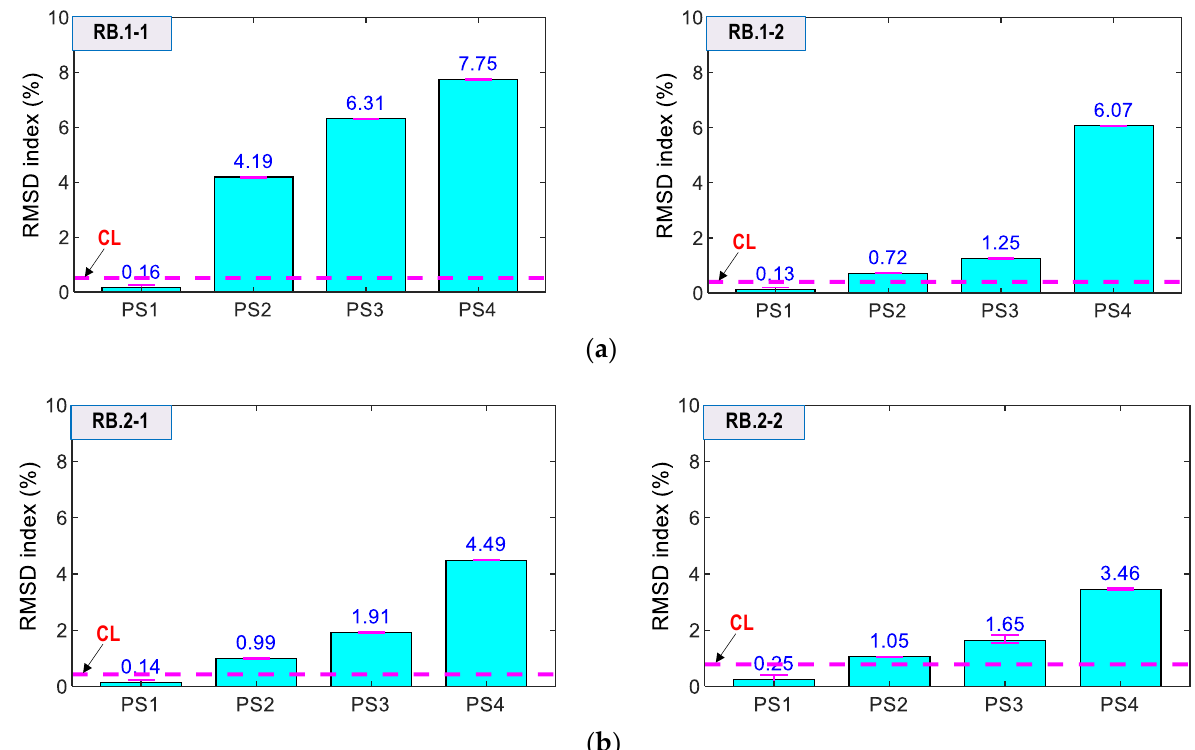
Figure 21. Impedance signatures of surface-mounted PZT sensors for loading cases PS1~PS4.